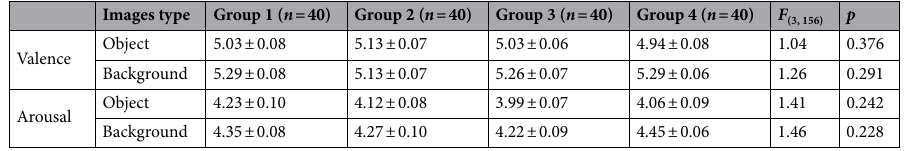
Table 1. Average valence and arousal ratings of image groups in the study phase. The data after “ ± ” in the table are the standard errors of the mean.